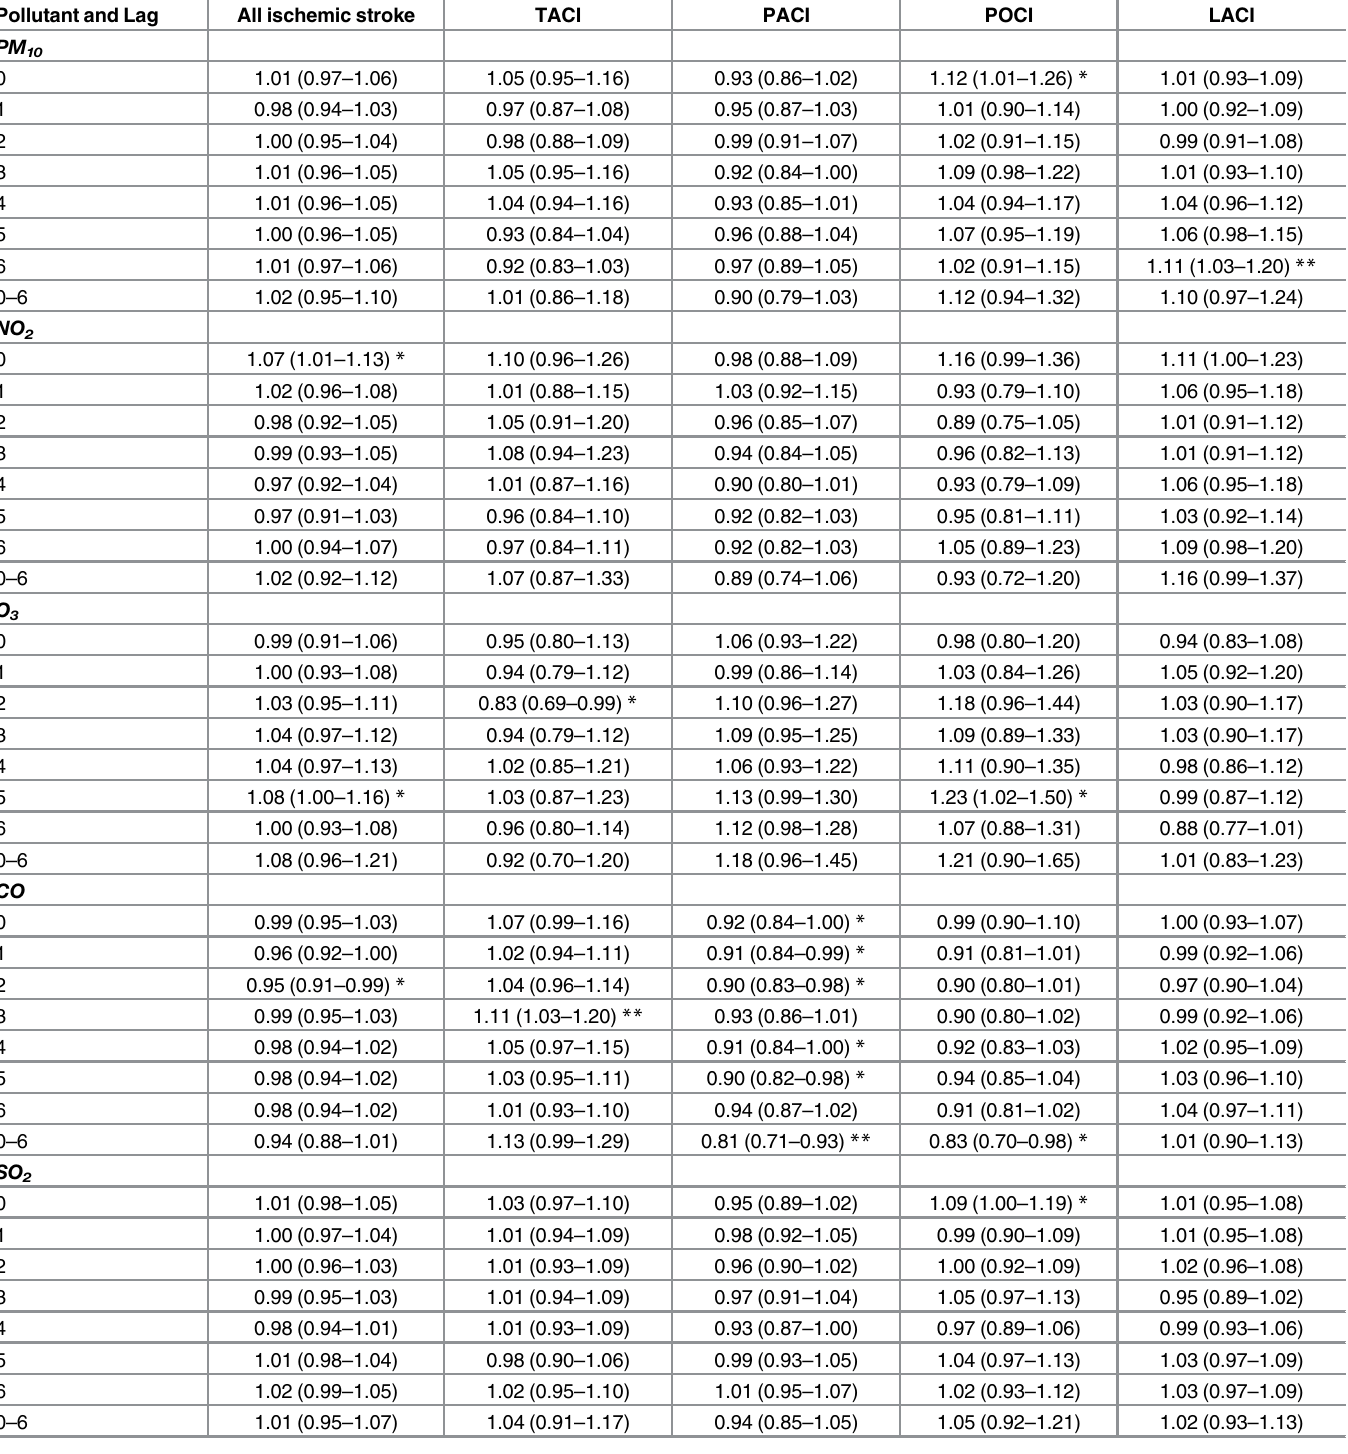
Table 3. Adjusted odds ratios (95% CI) for all ischemic stroke and ischemic stroke classified by clinical (Oxford) subtype associated with an inter- quartile range increase in outdoor air pollutants by lag interval, South London Stroke Register 1995 –